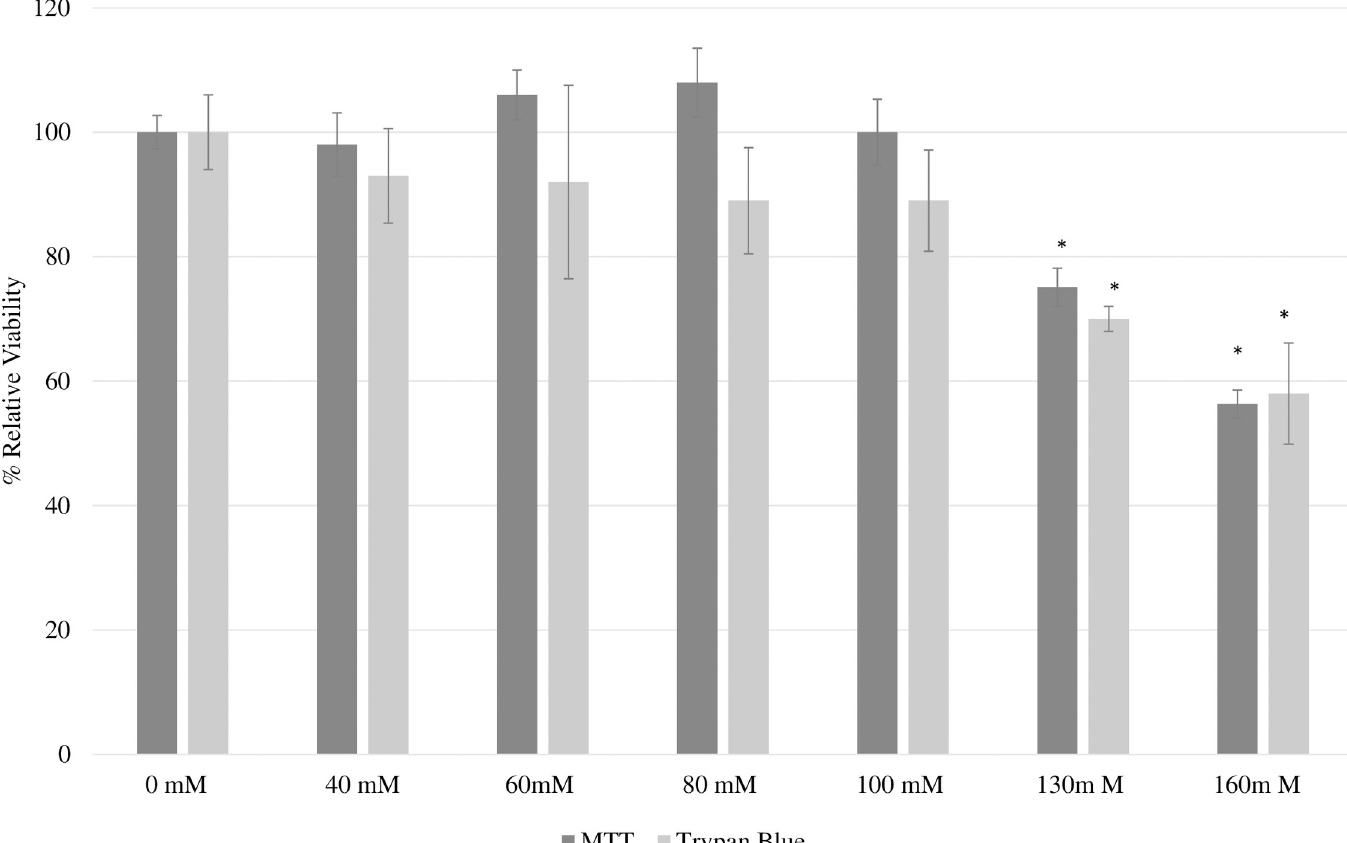
Fig 3. Effects of varying concentration of glucose on HepG2 cells viability measured by (A) MTT cells growth assay and (B) trypan blue exclusion method. HepG2 cells were exposed to complete DMEM media supplemented with varying concentrations of glucose (0–160 mM) for 24 hours and their viability was determined. The viability of the control was assumed to be 100% and the data are expressed as viability relative to the control. Each concentration was done in triplicate for both methods and the data is expressed as mean ± SEM. � Indicates statistically significant difference at P < 0.05.